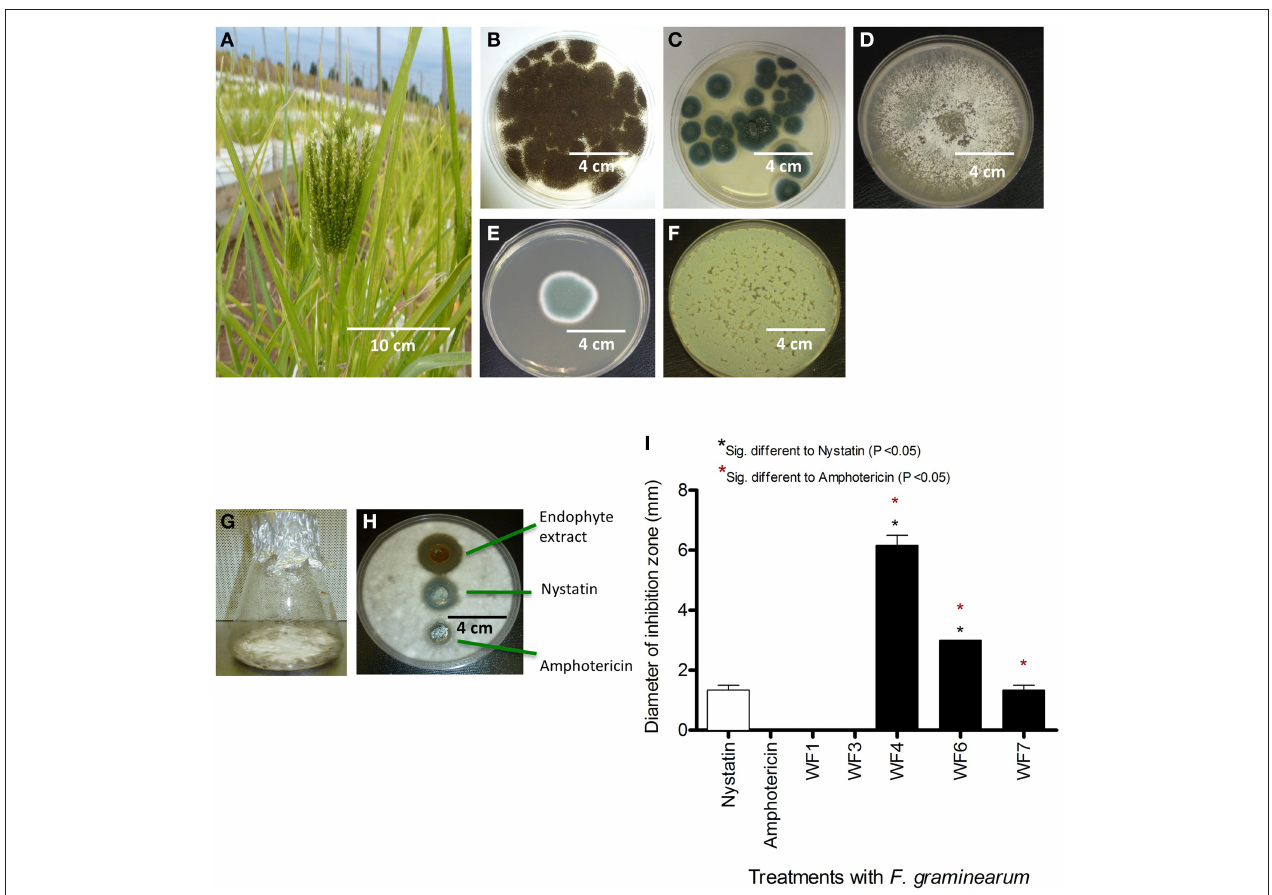
FIGURE 1 | Isolation of fungal endophytes from finger millet and screen for anti- Fusarium activity from endophyte extracts. (A) Picture of a finger millet plant. (B–F) Pictures of fungal endophytes isolated from finger millet roots, with the corresponding best BLAST match taxonomic identification in brackets based on 18S rDNA sequencing: (B) WF1 ( Aspergillus niger ), (C) WF3 ( Penicillium griseofulvum ), (D) WF4 ( Phoma sp.), (E) WF6 ( Penicillium chrysogenum ), (F) WF7 ( Penicillium expansum ). (G) An example of an endophyte fermented on rice medium. (H) Example of an endophyte extract showing suppression of F. graminearum hyphae (white) using the agar diffusion method, along with fungicide controls. (I) Quantification of the effects of different endophyte extracts on the growth of F. graminearum (diameter of inhibition zone, n = 3 ).